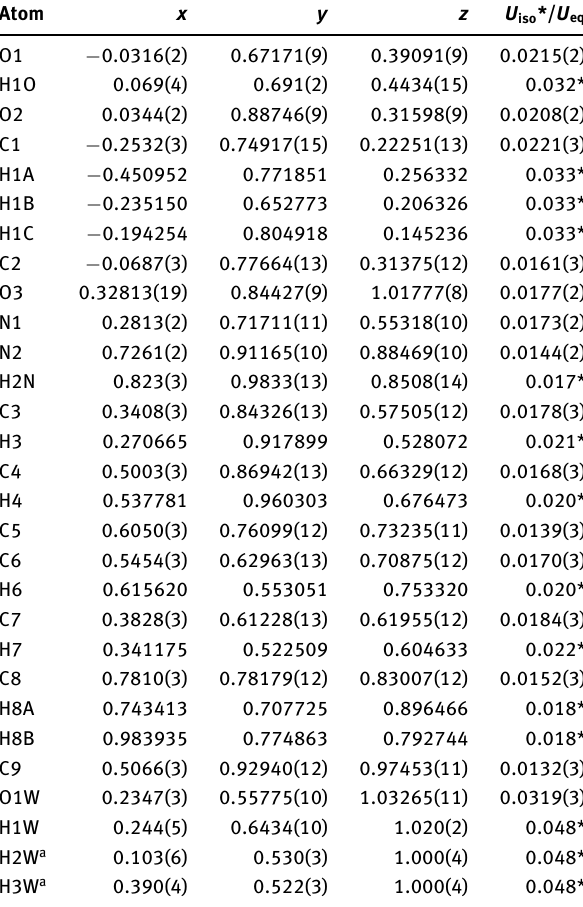
Table 2: Fractional atomic coordinates and isotropic or equivalent isotropic displacement parameters (Å 2